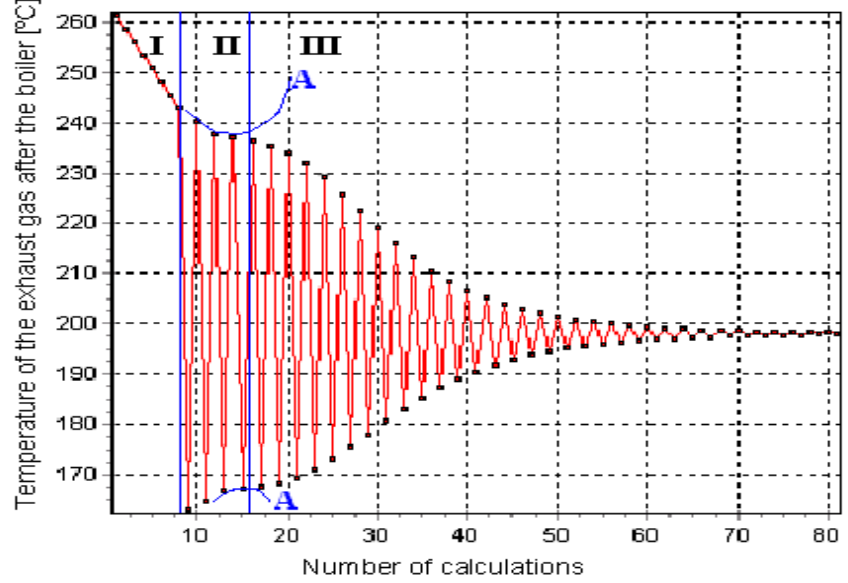
Figure 6. Stages of determining the temperature of the exhaust gas after the EGB (calculation stages I–III).